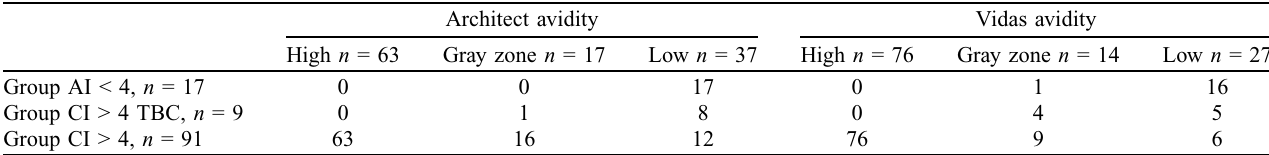
Table 1. Avidity data from Architect and Vidas assays according to the estimated date of infection established by IgG Vidas/IgG Architect ratio and IgM and IgA tests results.